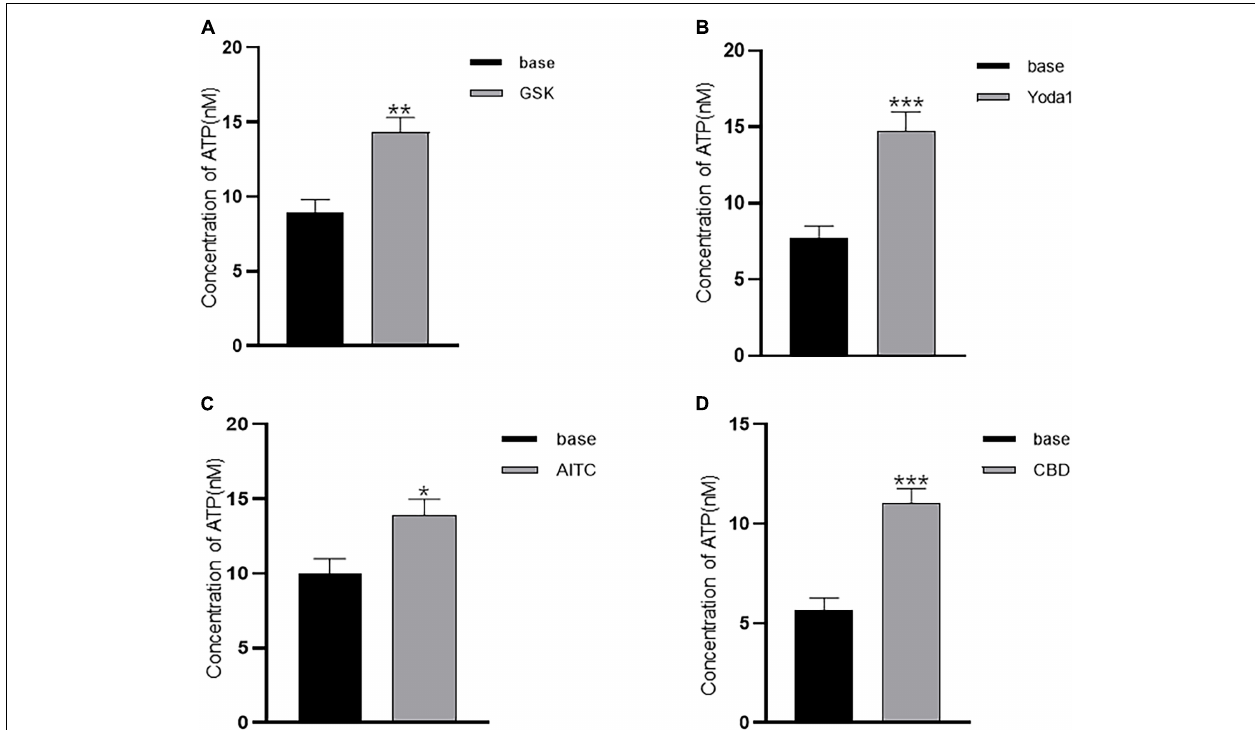
FIGURE 5 | Agonists of TRP (A1, V2, and V4) and Piezo1 channels elicit ATP release from cultured LP-ICs. Samples of perfusate were collected 2 min before (base) and immediately after stimulation with GSK (500 nM) (A) , Yoda-1 (30 µ M) (B) , AITC (100 µ M) (C) and CBD (10 µ M) (D) , and the ATP concentration in the perfusate was measured. The data for each figure is the average from 5 to 7 coverslips. * P < 0.05; ** P < 0.01; *** p <